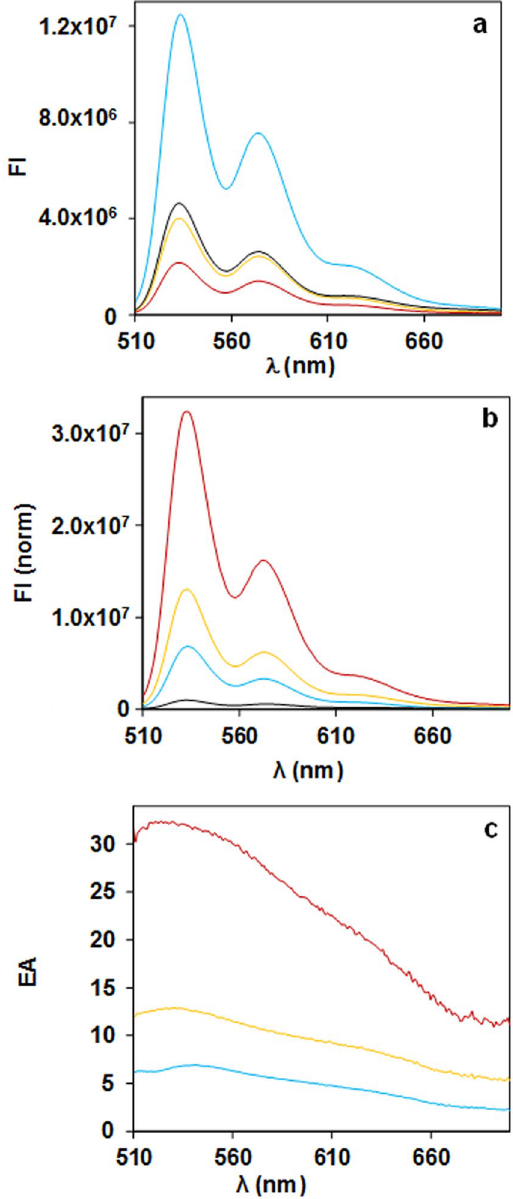
Figure 4. Emission spectra ( λ ex = 480 nm, right-angle acquisition in ethanol) normalized for the same PDI concentration, [PDI] = 10 − 6 M, obtained for SiNP-PDI (black curve), GNPSi13-PDI (blue curve), GNPSi9-PDI (yellow curve) and GNPSi7-PDI (red curve), before ( a ) and after ( b ) correction of the inner filter effects with equation (1). The corresponding emission intensity amplification curves calculated with equation (2), ( c ), show maxima around the GNPs